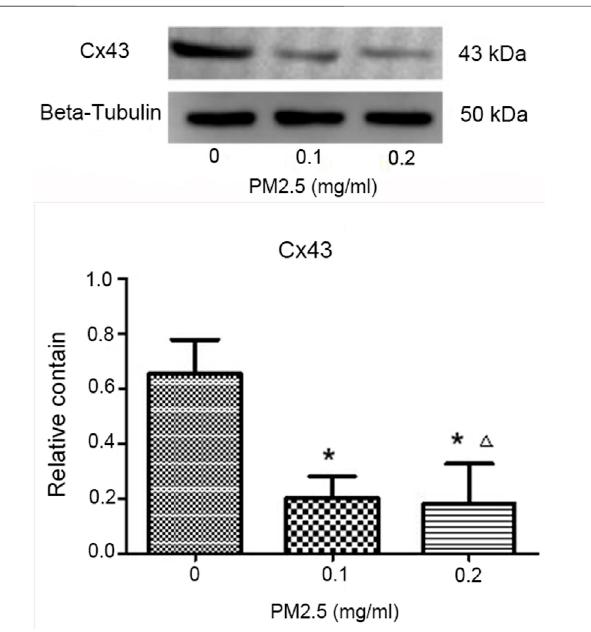
FIGURE 3 | Western blotting to analyze the protein expression of NF- κ B p65 and the relative protein expression of NF- κ B p65. Note: * p < 0.01, vs. control; △ p > 0.05, vs. low-dose group.